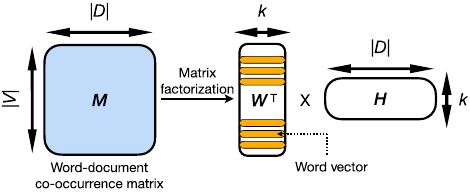
Fig. 8 An example of count-based model